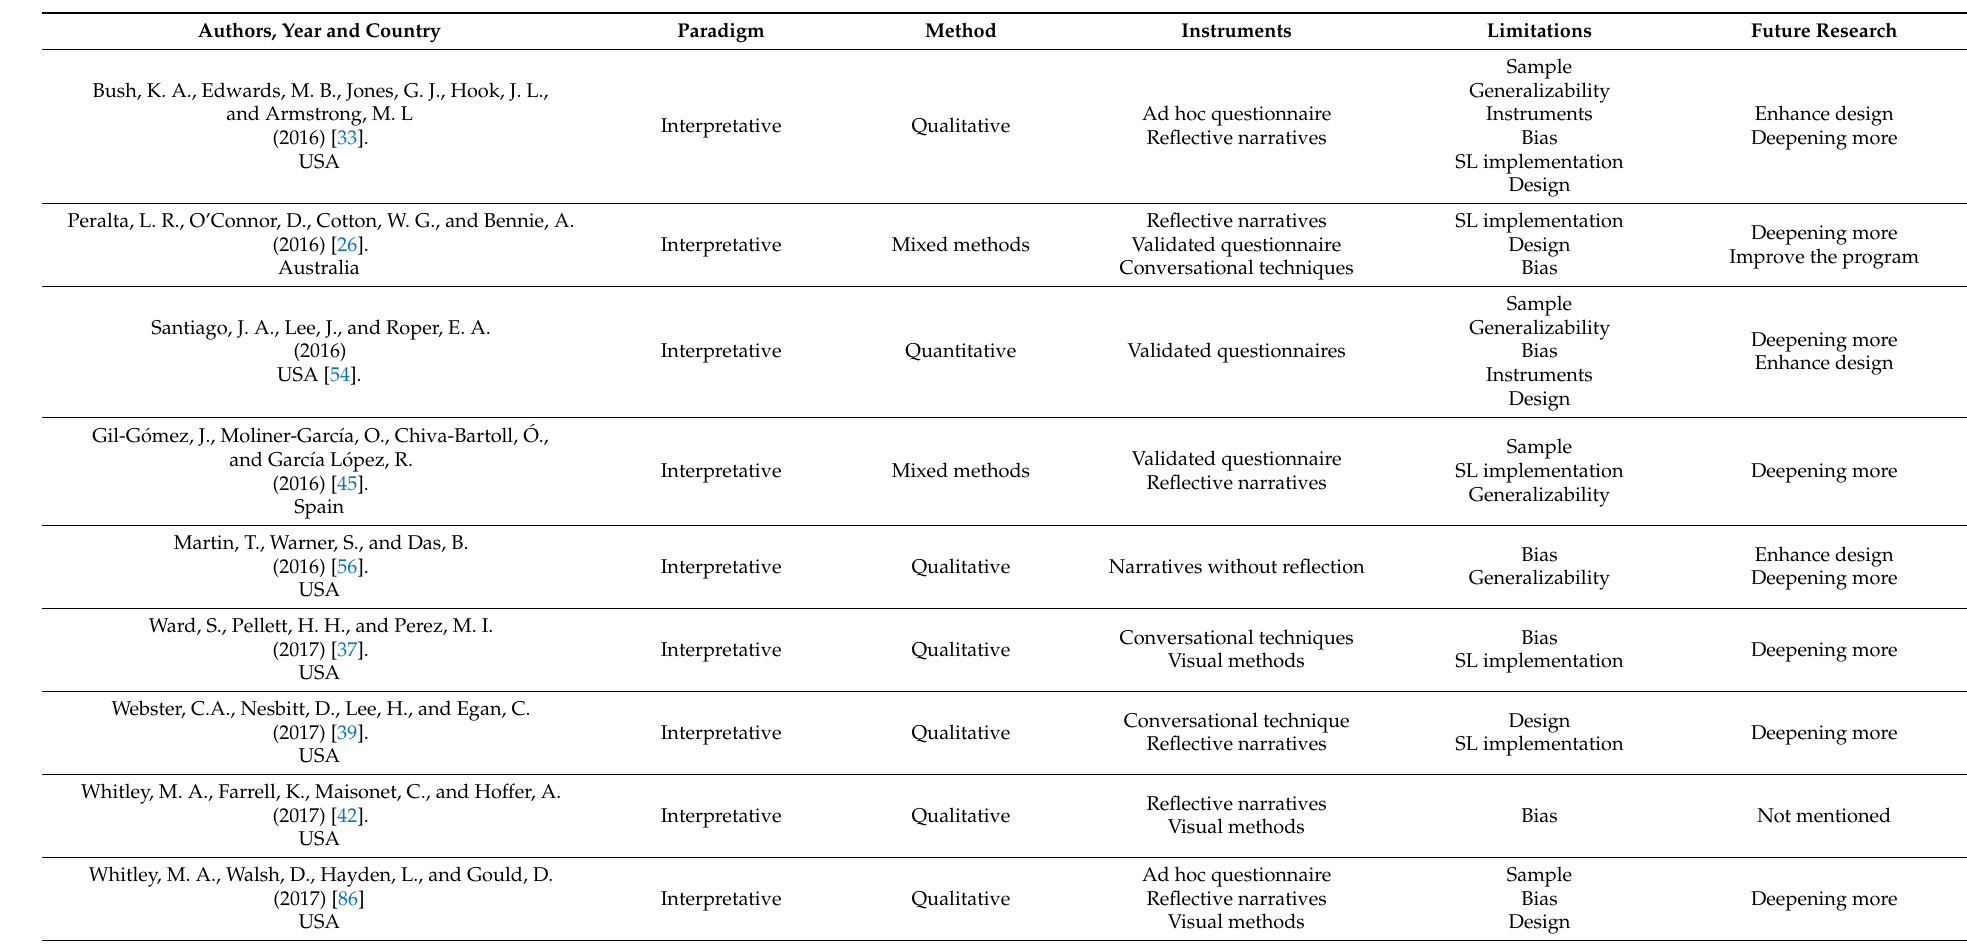
Table A1. Studies included in the final